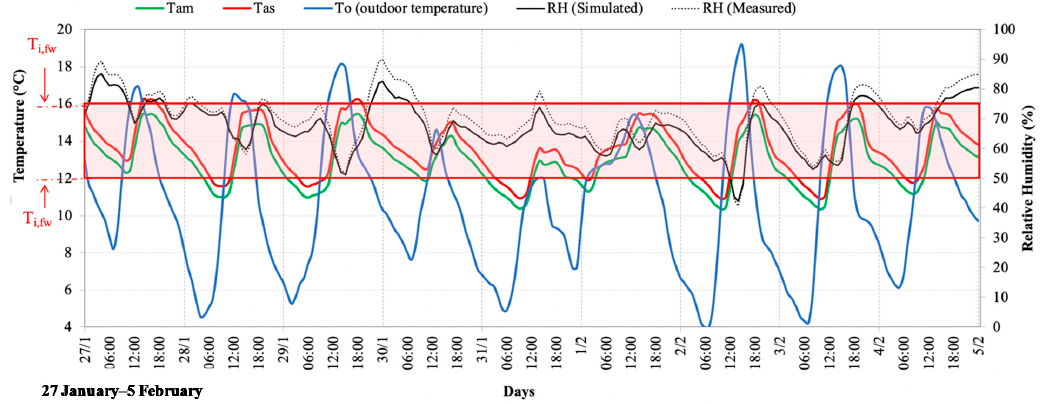
Figure 4. Daily profile of indoor temperatures at the current state of the building in free-running conditions during 27 January–5 February. Energies 2020 , 13 , x FOR PEER REVIEW